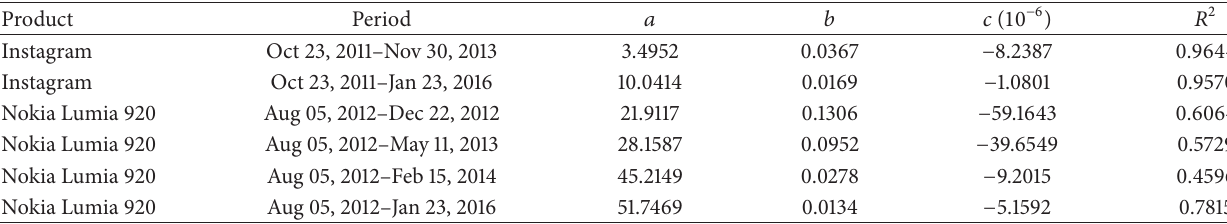
Table 2: Bass model regression